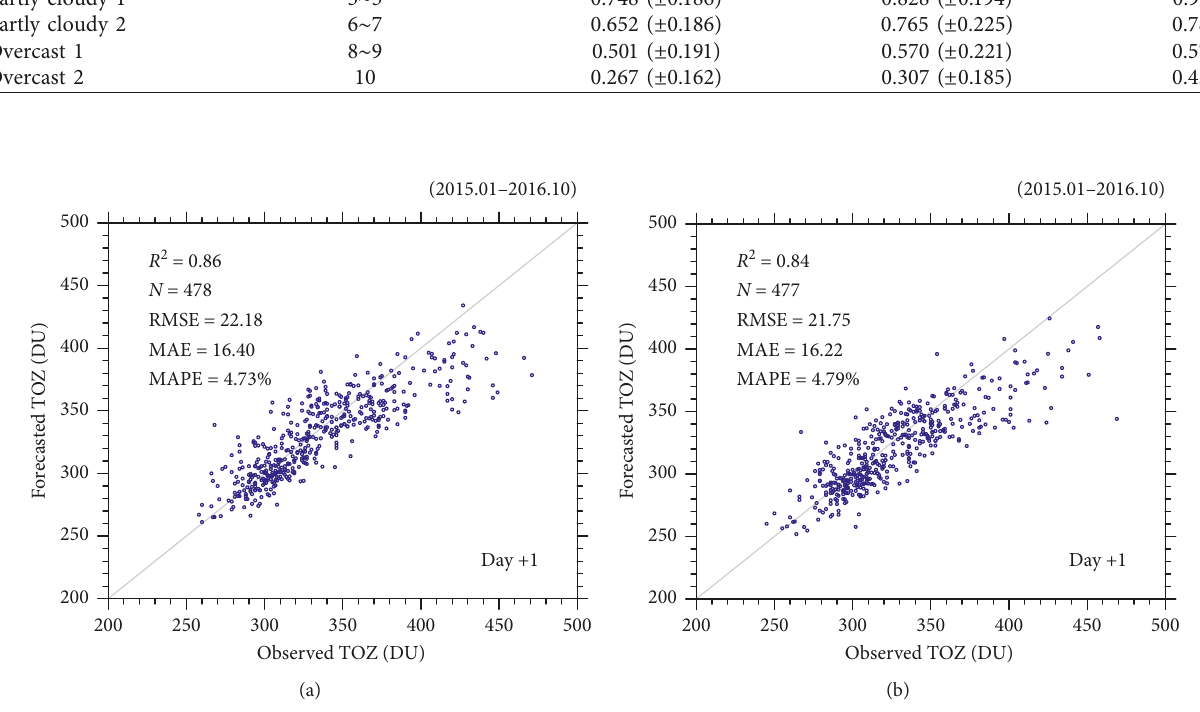
Figure 9: Scatter plot of total ozone between the observed and forecasted values in (a) Seoul and (b)